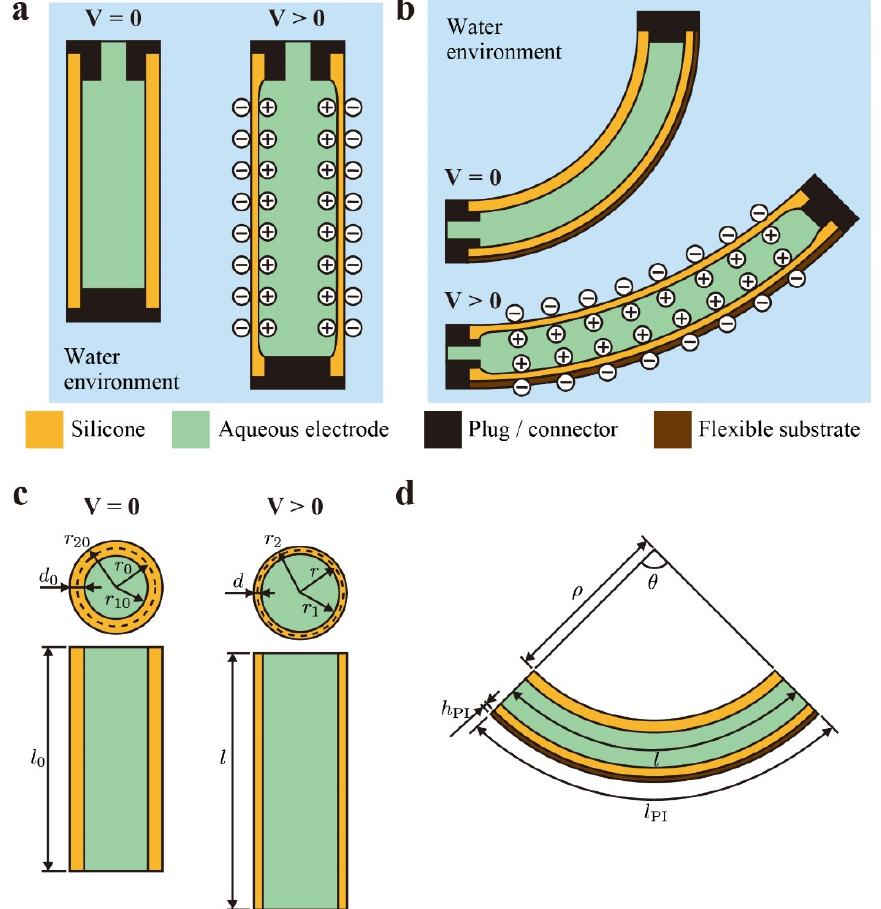
Figure 1. Working principle of ( a ) linear-type dielectric elastomer fiber actuators (DEFAs) and ( b ) bending-type DEFAs. ( c ) Schematics of linear-type DEFAs for modeling. ( d ) Schematics of bending-type DEFAs for modeling.